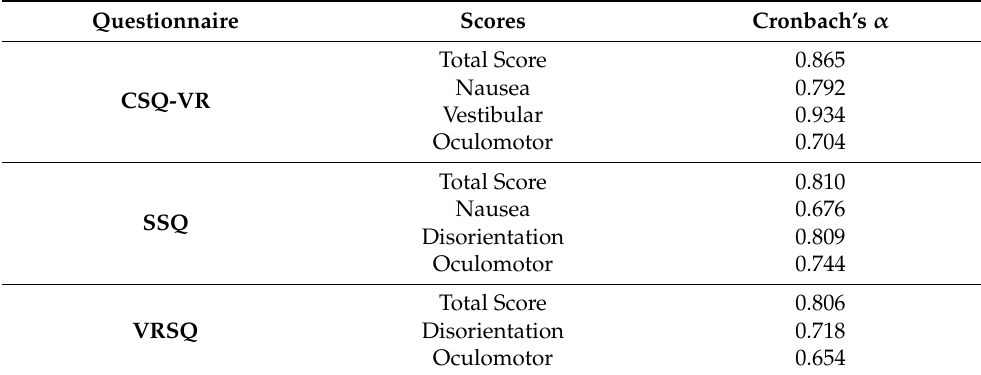
Table 3. Reliability (Internal Consistency) of CSQ-VR, SSQ, and VRSQ.